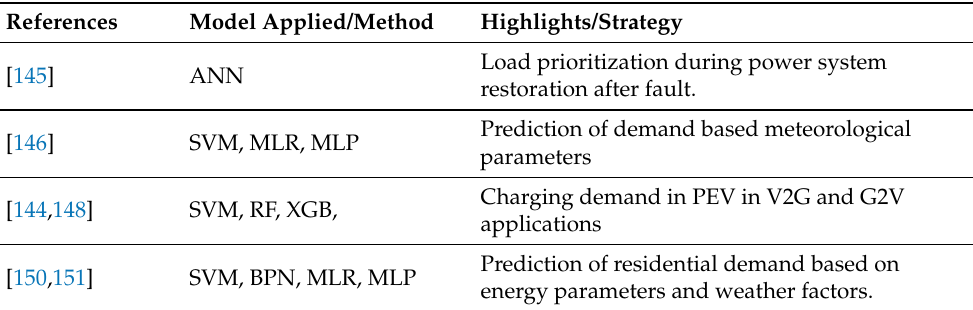
Table 4. Highlights of flexibility approach based on energy